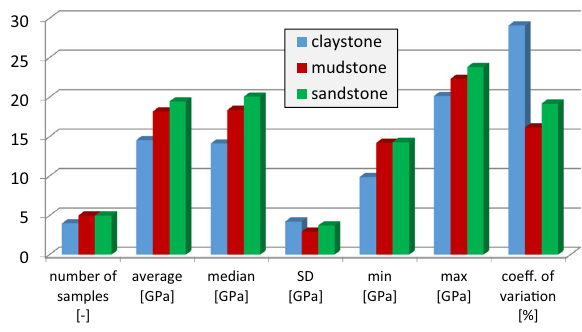
Fig. 7 Comparison of chosen statistical parameters for Young’s modulus data